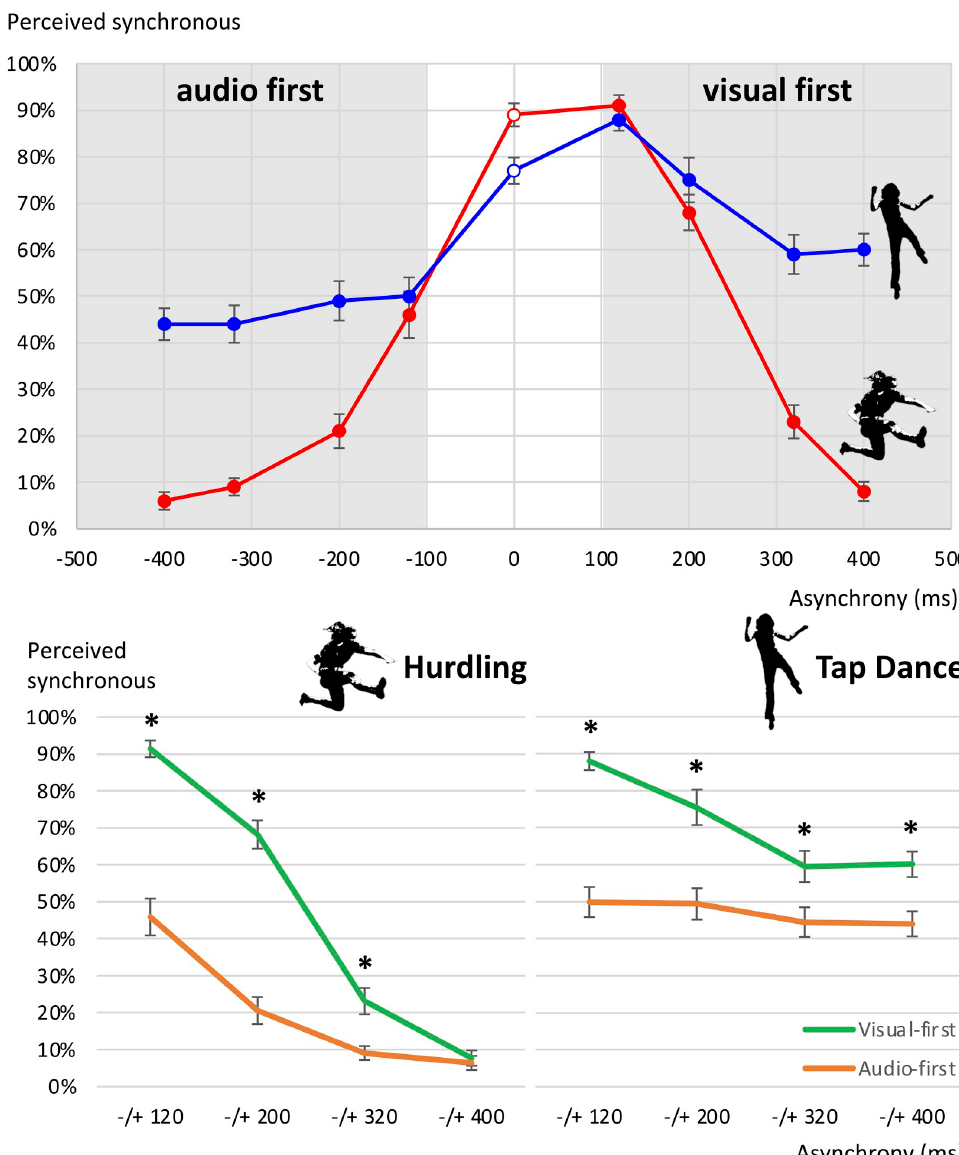
Fig 4. Mean percentages of trials perceived as synchronous, Study 1. Asynchronies (in ms) are displayed on the x-axis, with negative values indicating that the auditory channel preceded the visual channel (audio-first) and positive values indicating that the visual channel preceded the auditory channel (visual-first). Error bars show standard error of the mean. The upper panel shows all scores, fanned out for the level combinations of the factors asynchrony size, asynchrony type, and action type. The lower panel illustrates the significant action x asynchrony size x asynchrony type interaction.